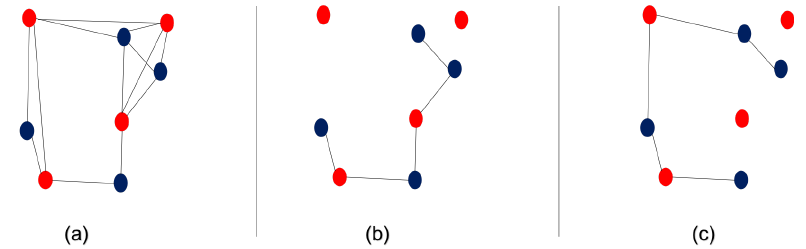
Figure 4. The visibility and optimal graphs of the example in Figure 3: ( a ) the visibility graph, ( b ) an optimal solution, and ( c ) another optimal solution.